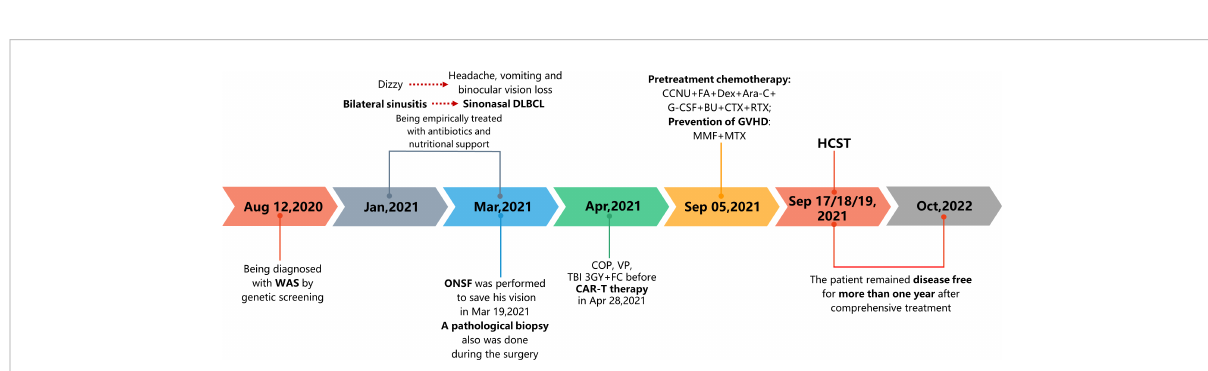
FIGURE 4 Timeline scheme of the major clinical events of the patient.WAS, Wiskott – Aldrich syndrome; ONSF, optic nerve sheath fenestration; COP, cyclophosphamide, vincristine, and prednisolone; VP, vinorelbine and prednisone; TBI, total body irradiation; FC, fl uorouracil and carboplatin; CAR-T therapy, chimeric antigen receptor T-cell immunotherapy; CCNU, lomustine; FA, fl udarabine; Dex, dexamethasone; Ara-C, cytosine arabinoside; G-CSF, granulocyte colony-stimulating factor; BU, busulfan; CTX, cyclophosphamide; RTX, rituximab; GVHD, graft-versus-host disease; MMF, mycophenolate mofetil; MTX, methotrexate; HSCT, hematopoietic stem-cell transplantation.